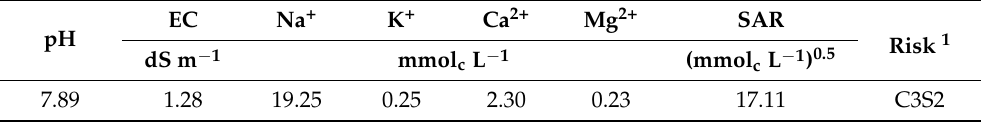
Table 1. Water characteristics: pH, electrical conductivity (EC), soluble cations (Na + , K + , Ca 2+ , and Mg 2+ ), sodium adsorption ratio (SAR), and Paje ú river water classification for salinity and sodicity